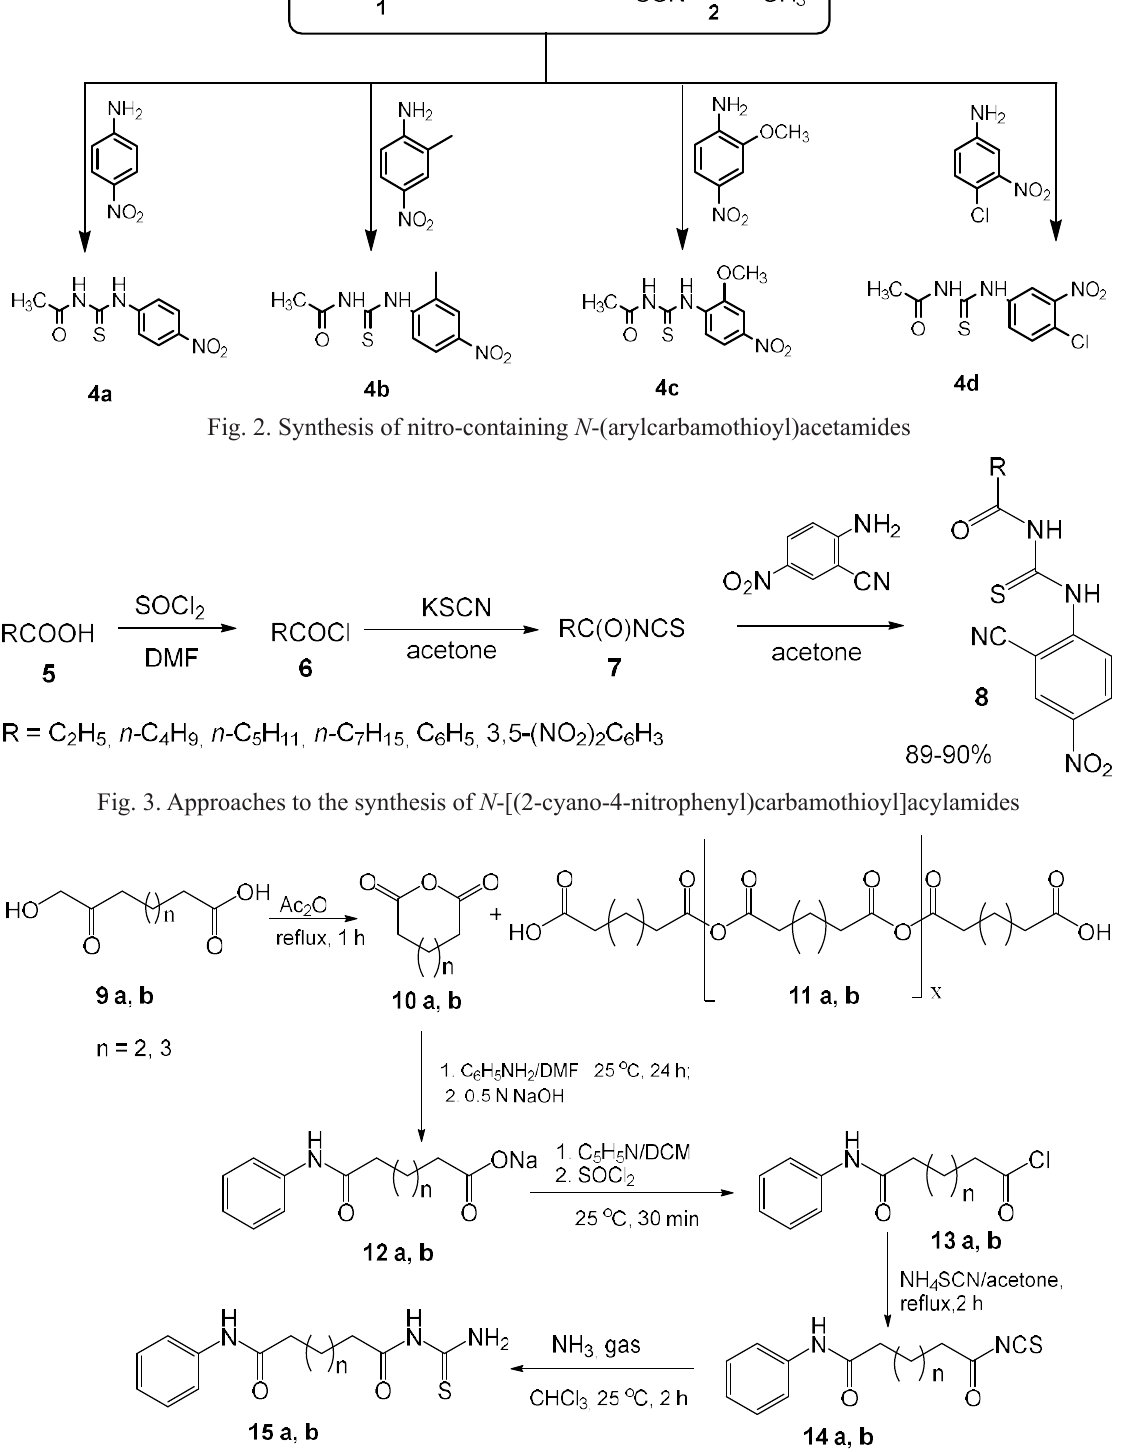
Fig. 4. Approaches to the synthesis of N 1 -carbamothioyl- N 6(7)